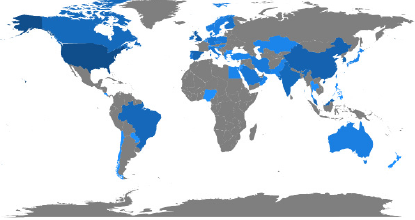
Figure 11. Country Scientific Production (ROI).